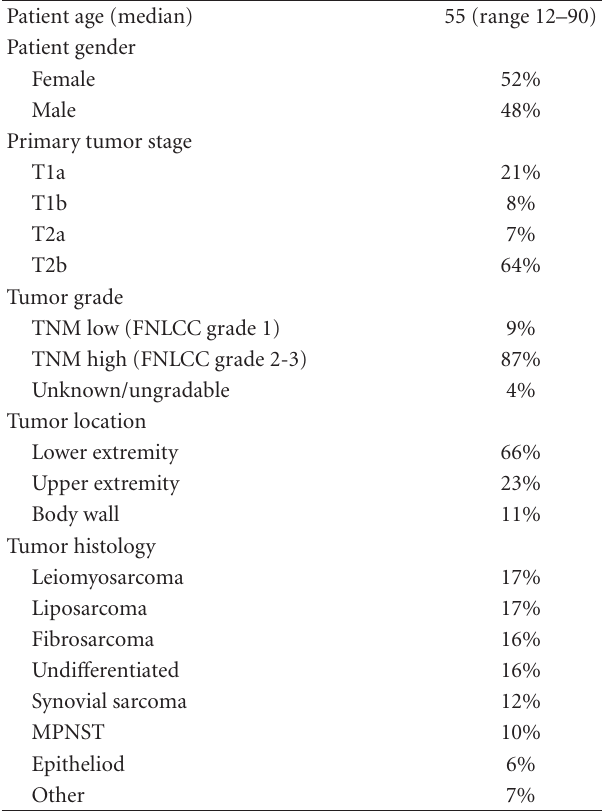
Table 1: Patient and tumor